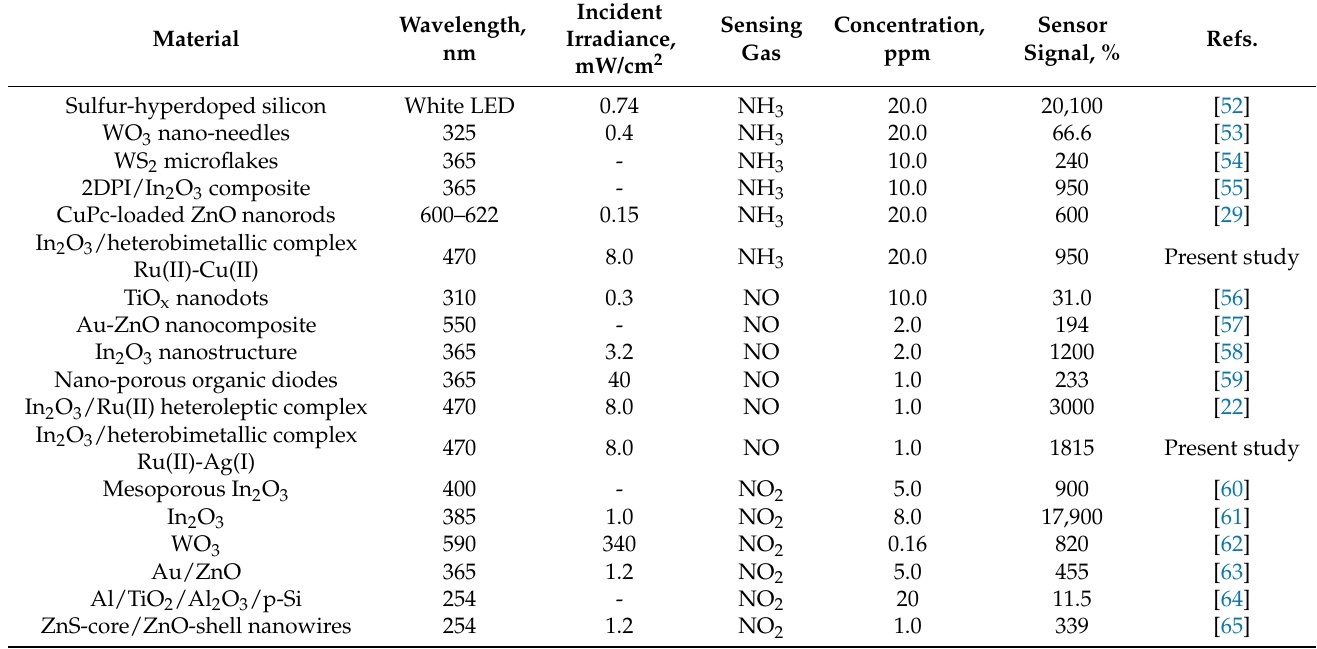
Table 3. Recent works comparing light-activated (with LED) NH 3 , NO, and NO 2 gas sensor per- formances at room temperature for different pure and composite materials. Sensor signals were recalculated as: